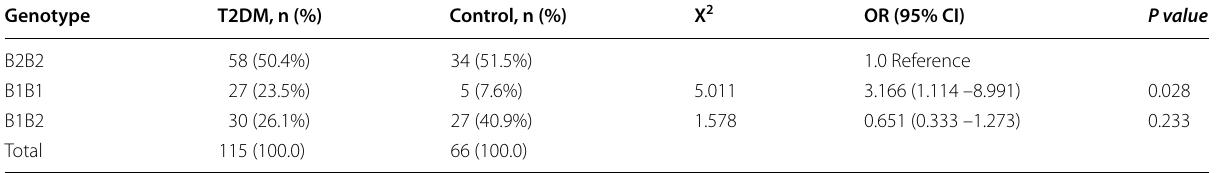
Comparisons were performed by Chi-squared test Significant differences between groups (P < 0.05). T2DM, type 2 diabetes mellitus; OR, odds ratio; CI, confidence